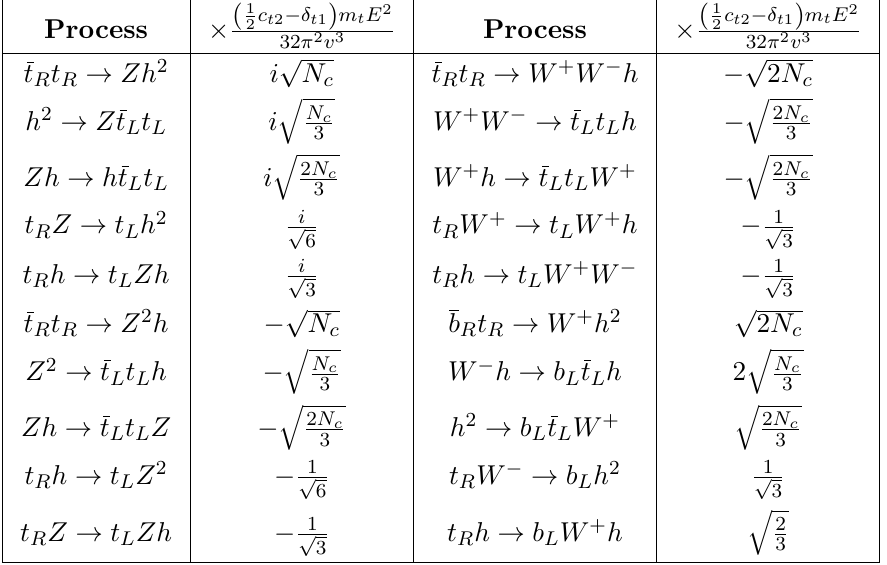
Table 8 . 5-body unitarity-violating processes that depend on c t 2 and δ t 1